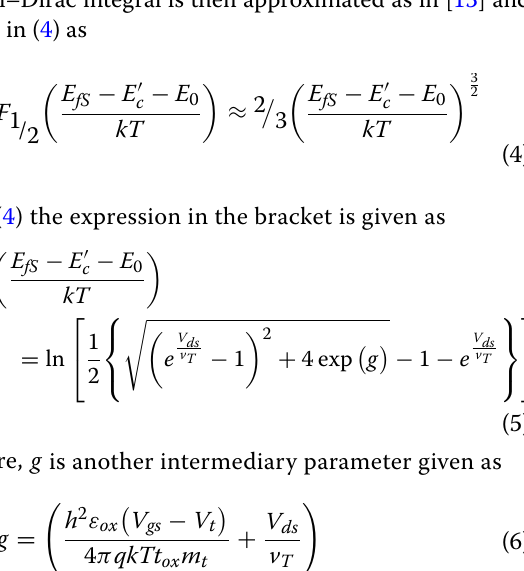
8 √ 2 m t qW ( kT ) 3 / 2 G h 2 as in [12]. The =